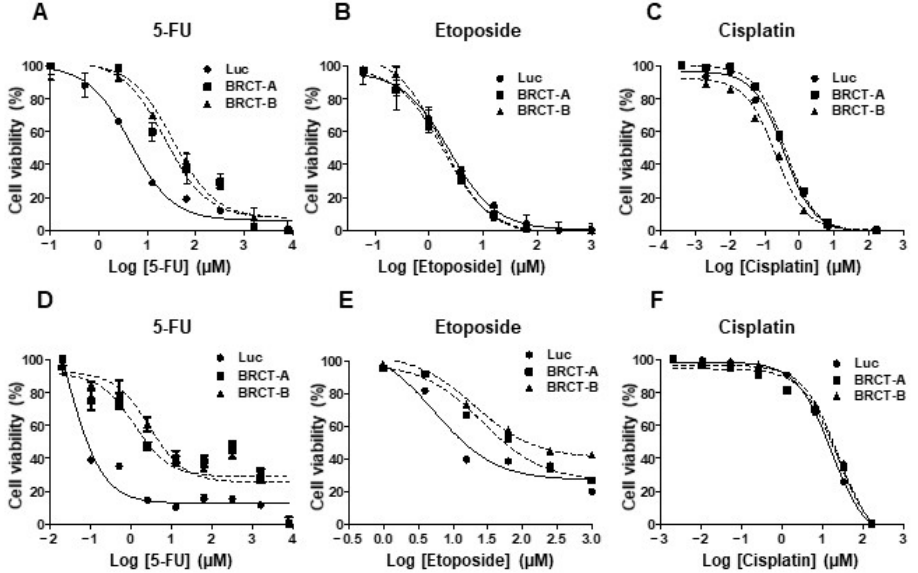
Figure 6. Effect of BRCT domain from LmjPES protein expression on drug-induced cell death. Percentage of cell viability of HEK293T ( A – C ) and NIH/3T3 ( D – F ) cells infected with lentiLuc (Luc) or lentiBRCT (BRCT-A and BRCT-B) after 48 or 72 h of treatments with increasing amounts of 5-Fluorouracil (5-FU) ( A , D ), etoposide ( B , E ) or cisplatin ( C , F ) drugs. The values represent the mean ± SD of triplicates from three independent experiments carried out. Table 1. IC 50 values of DNA-damaging agents on mammalian cells expressing the BRCT domain from LmjPES molecule (BRCT-A and BRCT-B) or expressing luciferase (Luc) as control. Condition 5-Fluorouracil ( µ M) Etoposide ( µ M) Cisplatin ( µ M) HEK293T-Luc HEK293T-BRCT-A HEK293T-BRCT-B